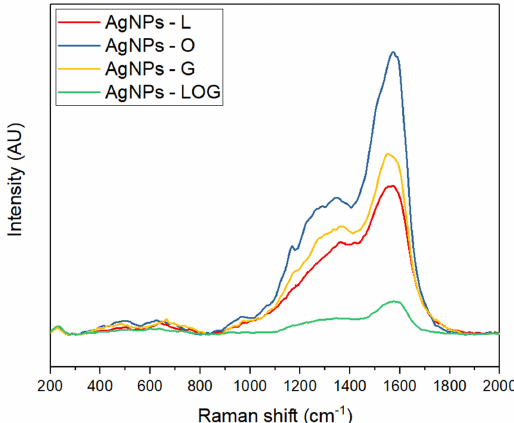
Figure 9. Raman spectra of the AgNPs synthesized using citrus peels extracts. (Red) AgNPs synthe- sized with lemon extract. (Blue) AgNPs synthesized with orange extract. (Yellow) AgNPs synthe- sized with lemon and grapefruit extract. (Green) AgNPs synthesized with a mixture of lemon, or- ange, and grapefruit extracts. 3.2. Antimicrobial Activity The antibacterial activity of the synthesized AgNPs against clinical multidrug-re- sistant Staphylococcus aureus (SaR) was evaluated using the serial dilution method. As the concentration of AgNPs decreased, bacterial growth increased. However, the AgNPs syn- thesized with lemon peel extract and a combination of extracts exhibited the lowest con- centration (15.625 μ g/mL) at which the bacteria grew, while the AgNPs synthesized with orange peel extract showed inhibition at 62.5 μ g/mL. Notably, the AgNPs synthesized with grapefruit peel extract exhibited no bacterial growth at all. The minimum inhibitory concentration (MIC) values of the citrus peel extracts and the AgNPs were determined over a 22-hour interval, and the results are shown in Figures 10–14. Overall, the results indicate that silver nanoparticles have a significant inhibitory effect on the growth of re- sistant S. aureus .